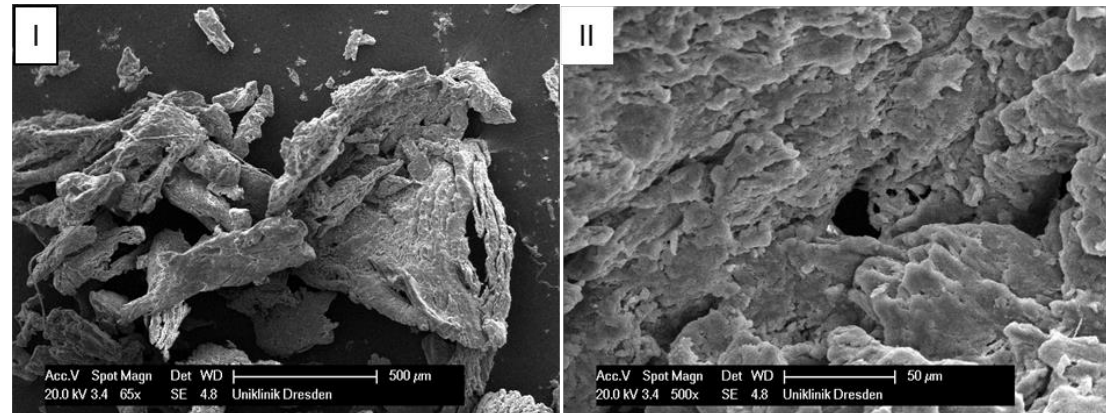
Figure 8. Scanning electron microscope images of bone chips in wet room mode ( I ) and sputtered with gold in high vacuum ( II ).